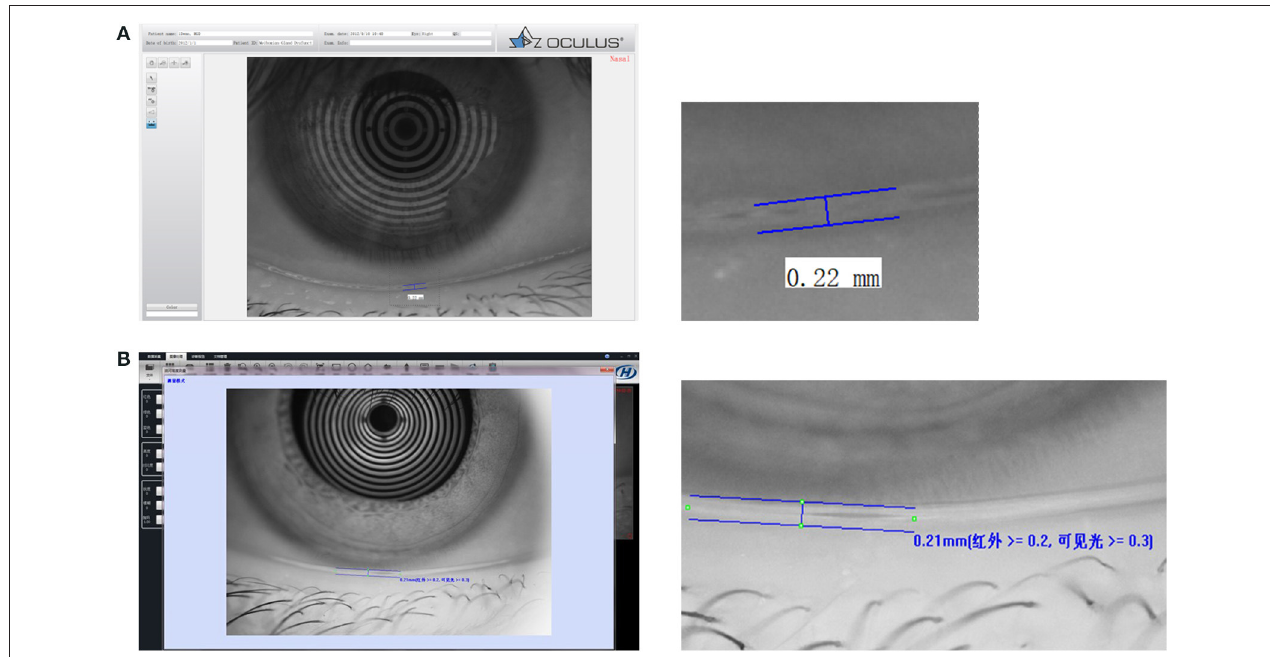
FIGURE 1 | Tear film thickness. (A) An example of tear film thickness from OCULUS Keratograph 5M. (B) An example of tear film thickness from Kanghua dry eye analyzer.